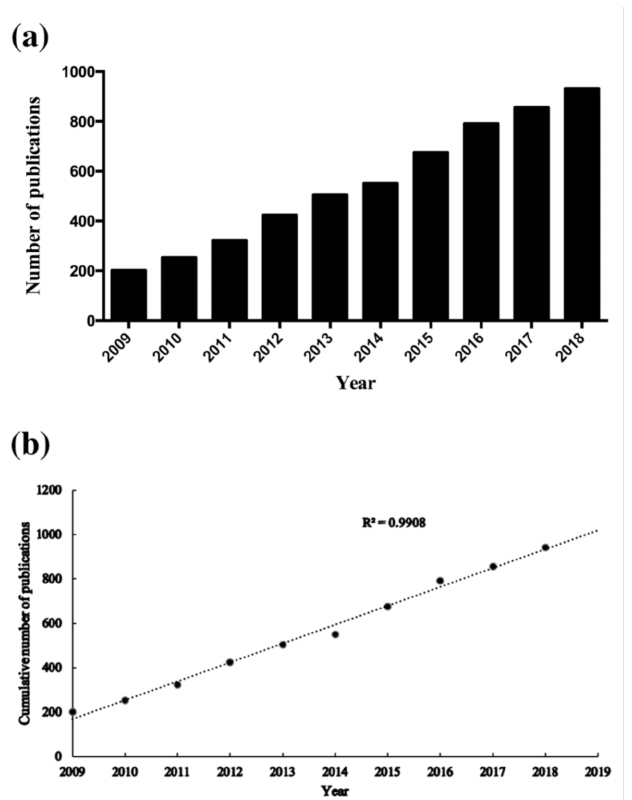
Figure 2. Publication outputs and growth prediction. ( a ) The number of annual publications on QDs toxicity research from 2009 to 2018; ( b ) The model-fitting curve of the growth trend of publications on QDs